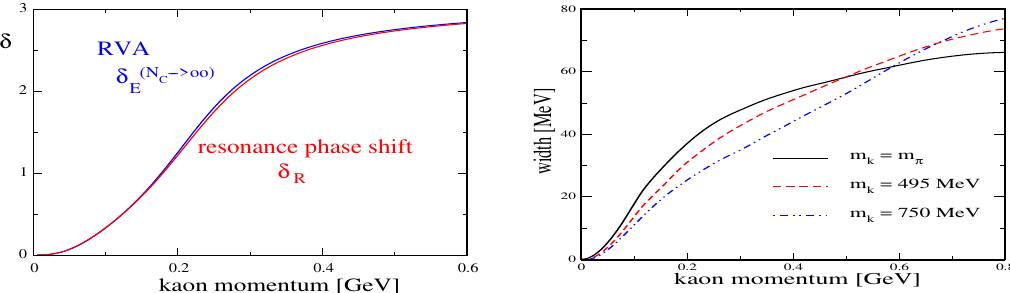
Figure 3. (Color online) Skyrme model results for phase shifts and decay widths of kaon nucleon scattering in the Θ +